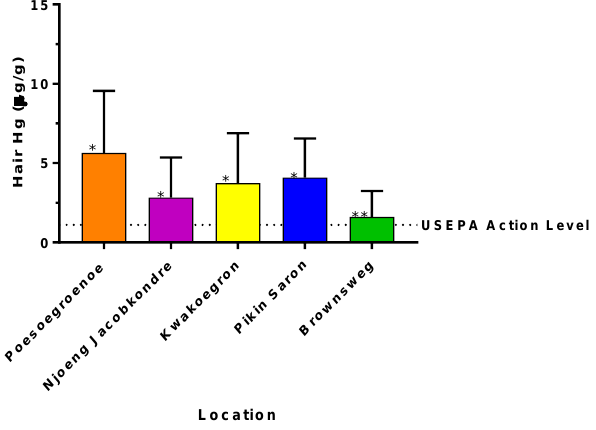
the USEPA’s action level.